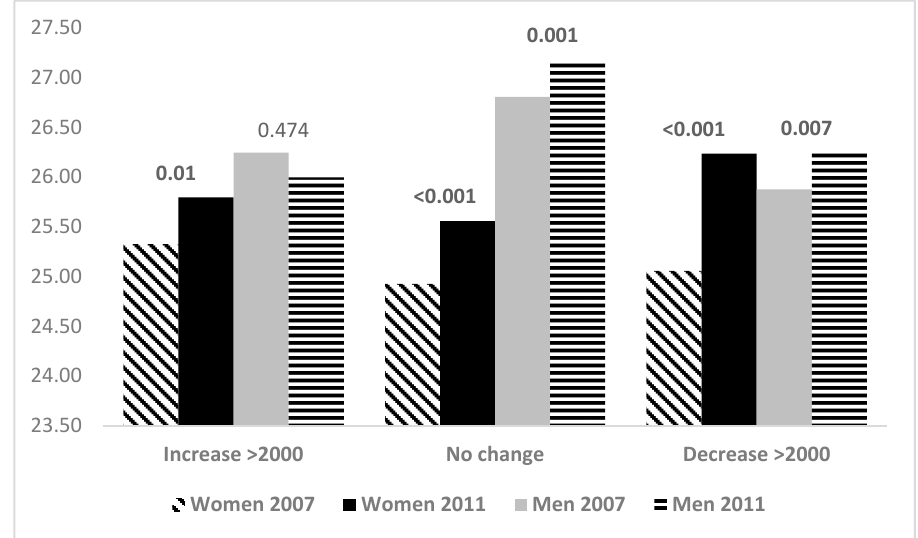
Figure 1. BMI in 2007 and 2011 in women and men according to change groups (increase, maintain or decrease) of total steps from 2007 to 2011. p -values for difference between 2007 and 2011.